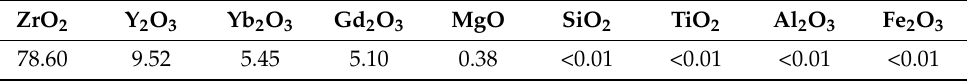
Table 4. Chemical compositions of YGYZ calcined powders at 1400 ◦ C for 3 h (in